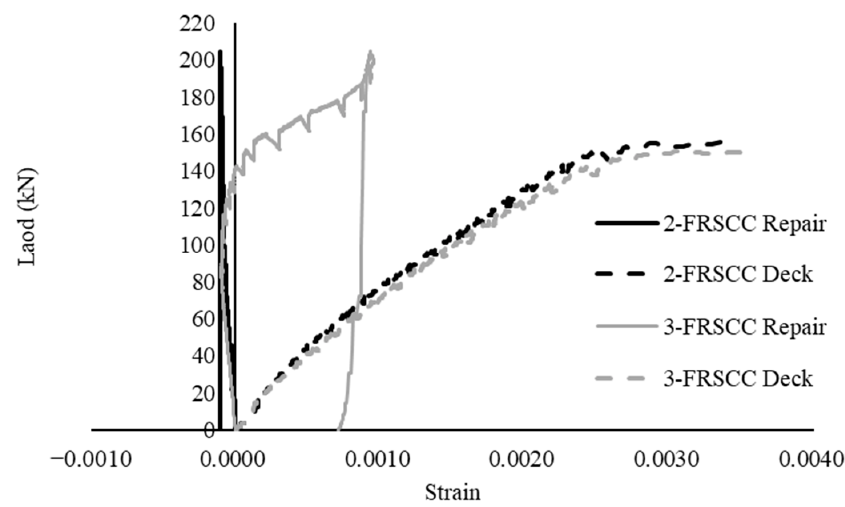
Figure 15. Load vs. deflection plot for connected girder specimens repaired with FRSCC.